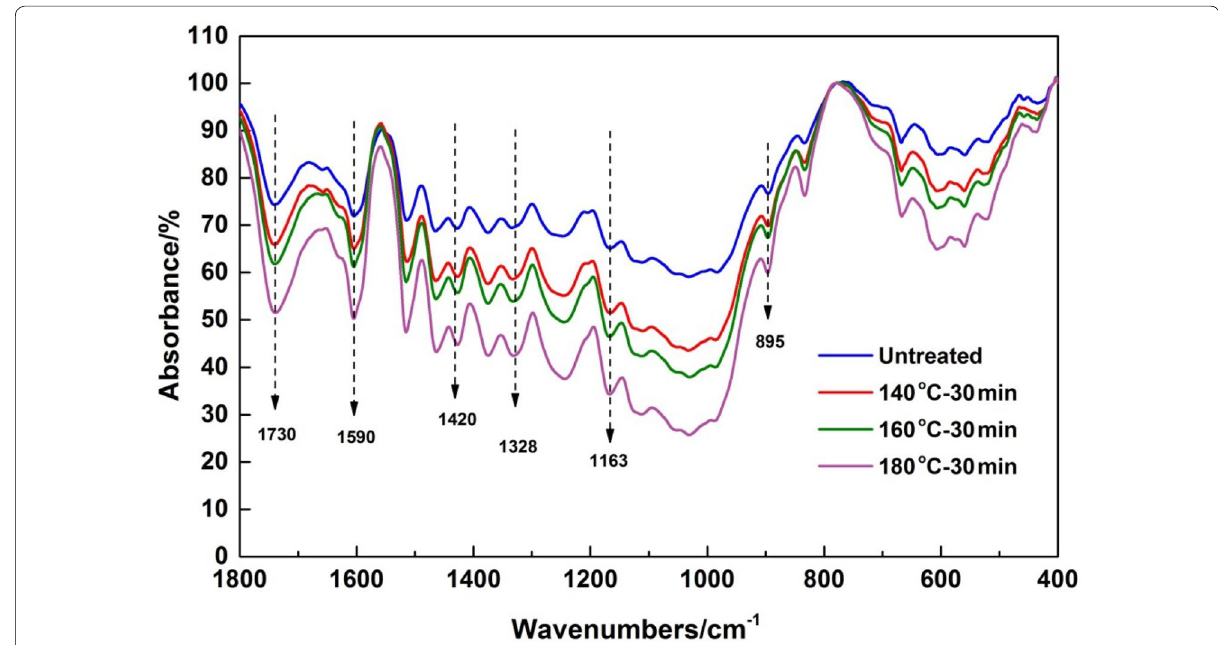
Fig. 4 FTIR spectra for bamboo